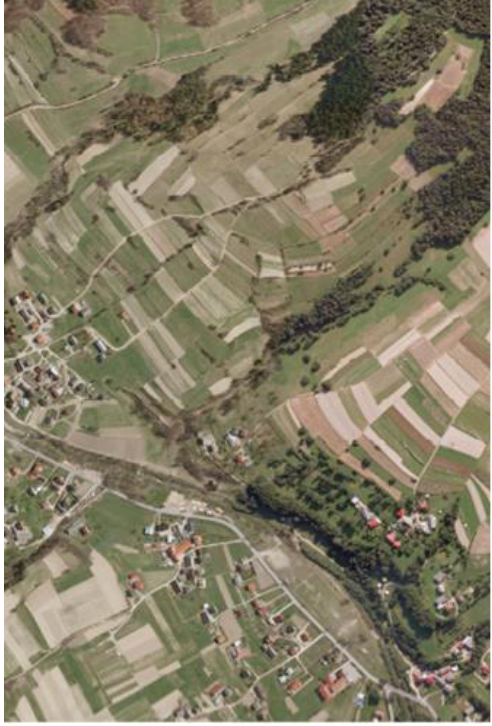
Figure 5. Orthophotomap from 1963.